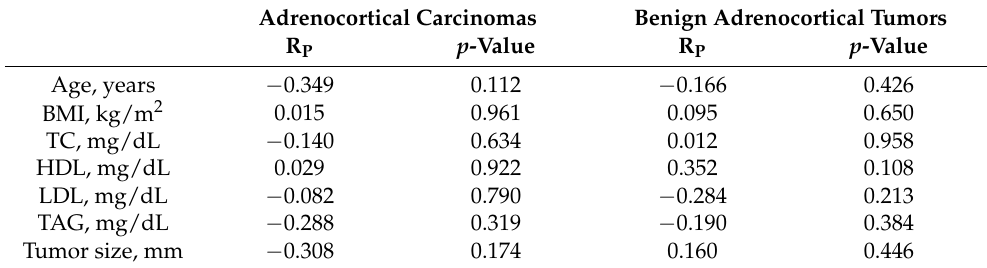
Table 3. Correlation coefficients (R) for visfatin serum level and clinicopathological parameters.